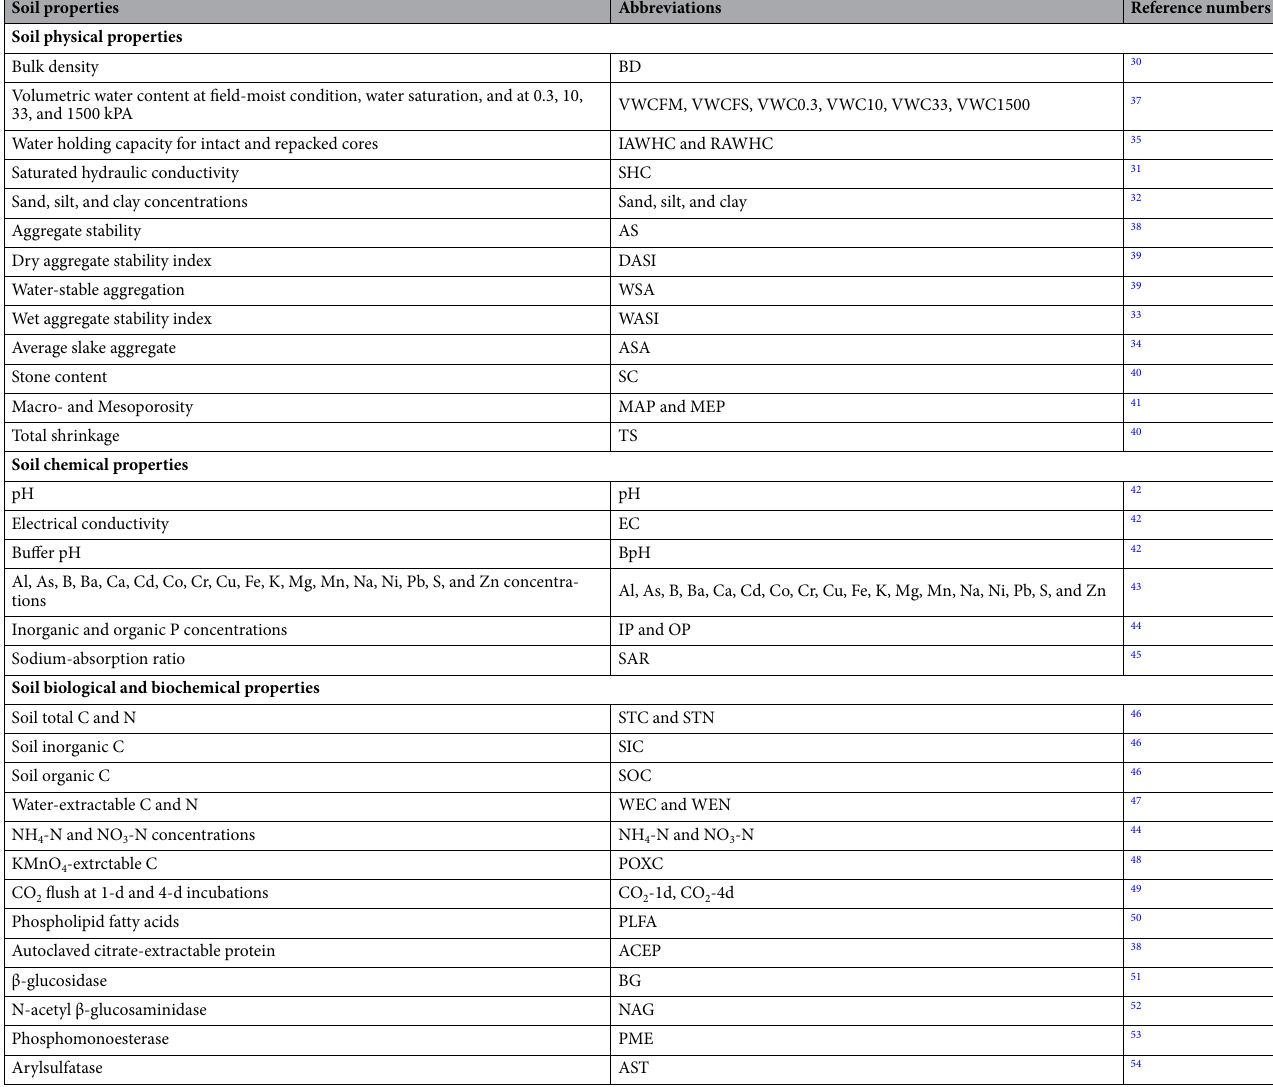
Table 2. Determination of soil physical, chemical, biological, and biochemical